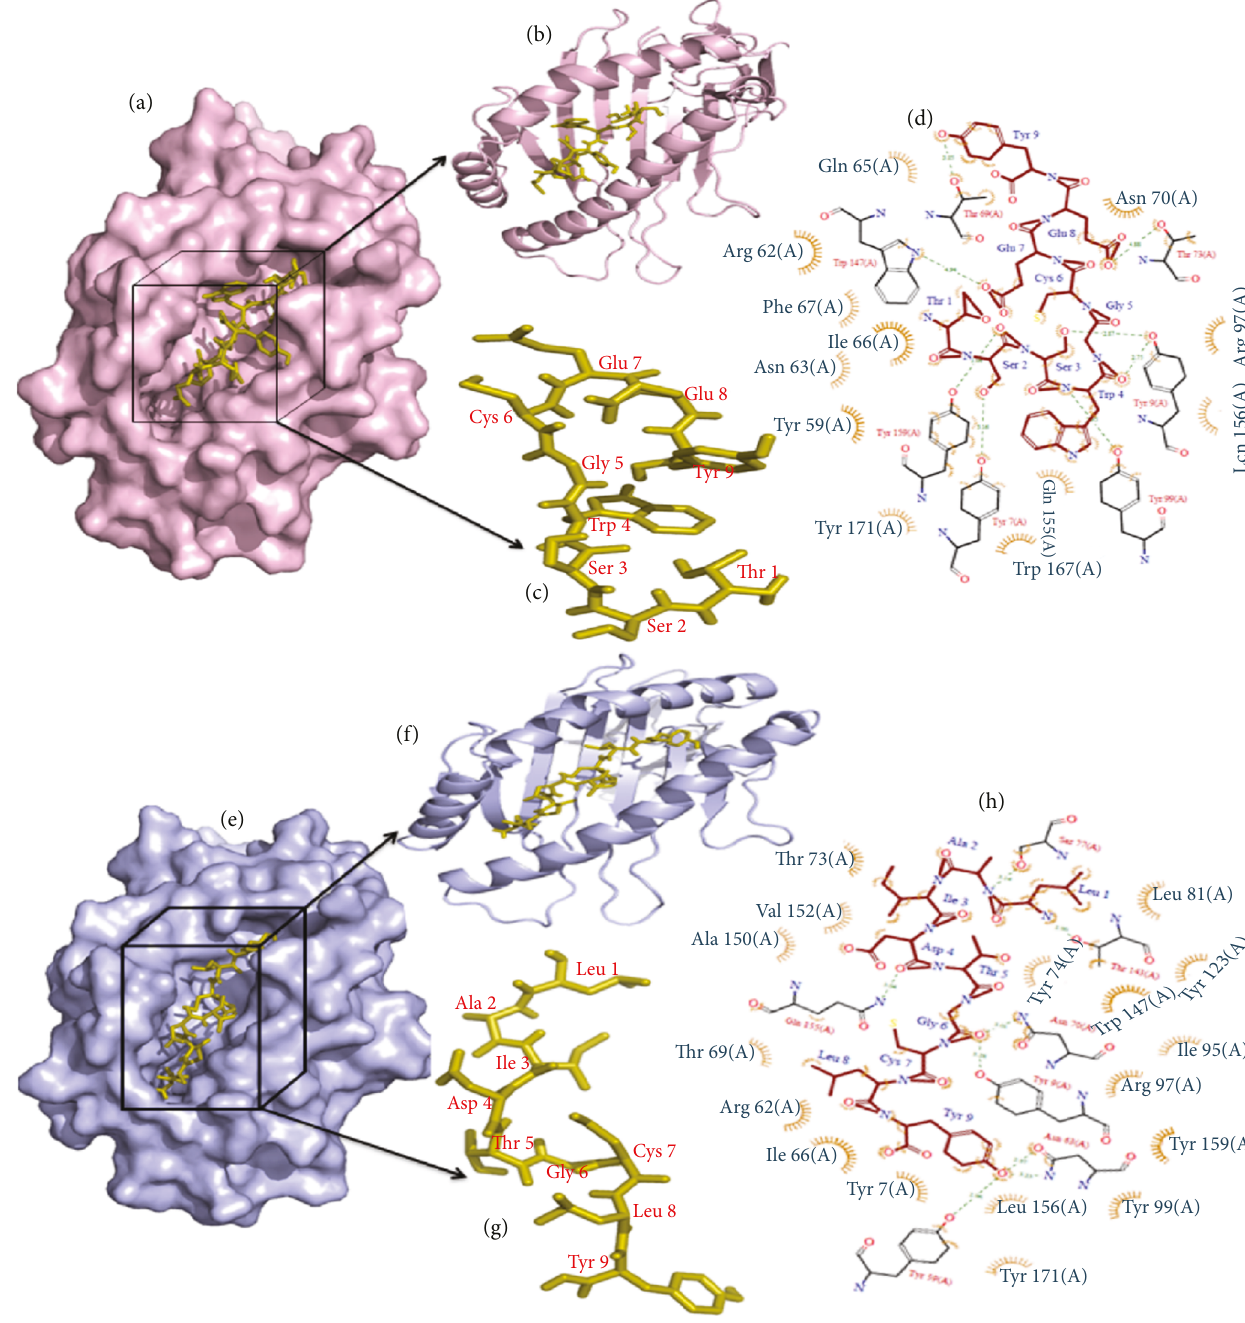
Figure 3: Docking simulation study (sample). (a) The docking results as the surface structure of the MHC-I HLA allele “ HLA-B ∗ 35:01 ” (tint light pink color) and the sticky form of epitope “ TSSWGCEEY ” (orange olive color). The black color box represents the position of epitope in the surface structure. (b) Epitope in the cartoon structure. (c) Sticky form of epitope “ TSSWGCEEY ” (orange olive color) with residue ’ s position. (d) Binding interaction of the epitope residues and the HLA-B ∗ 35:01 residues through the hydrogen bonds. Hydrogen bonds and the distances are shown in green color. (e) The docking results as the surface structure of the MHC-I HLA allele “ HLA-B ∗ 35:01 ” (tint light blue color) and the sticky form of epitope “ LAIDTGCLY ” (orange olive color). The black color box represents the position of epitope in the surface structure. (f) Epitope LAIDTGCLY in the cartoon structure. (g) Sticky form of epitope “ LAIDTGCLY ” (orange olive color) with residue ’ s position. (h) Binding interaction of the epitope residues and the HLA-B ∗ 35:01 residues through the hydrogen bonds. Hydrogen bonds and the distances are shown in green